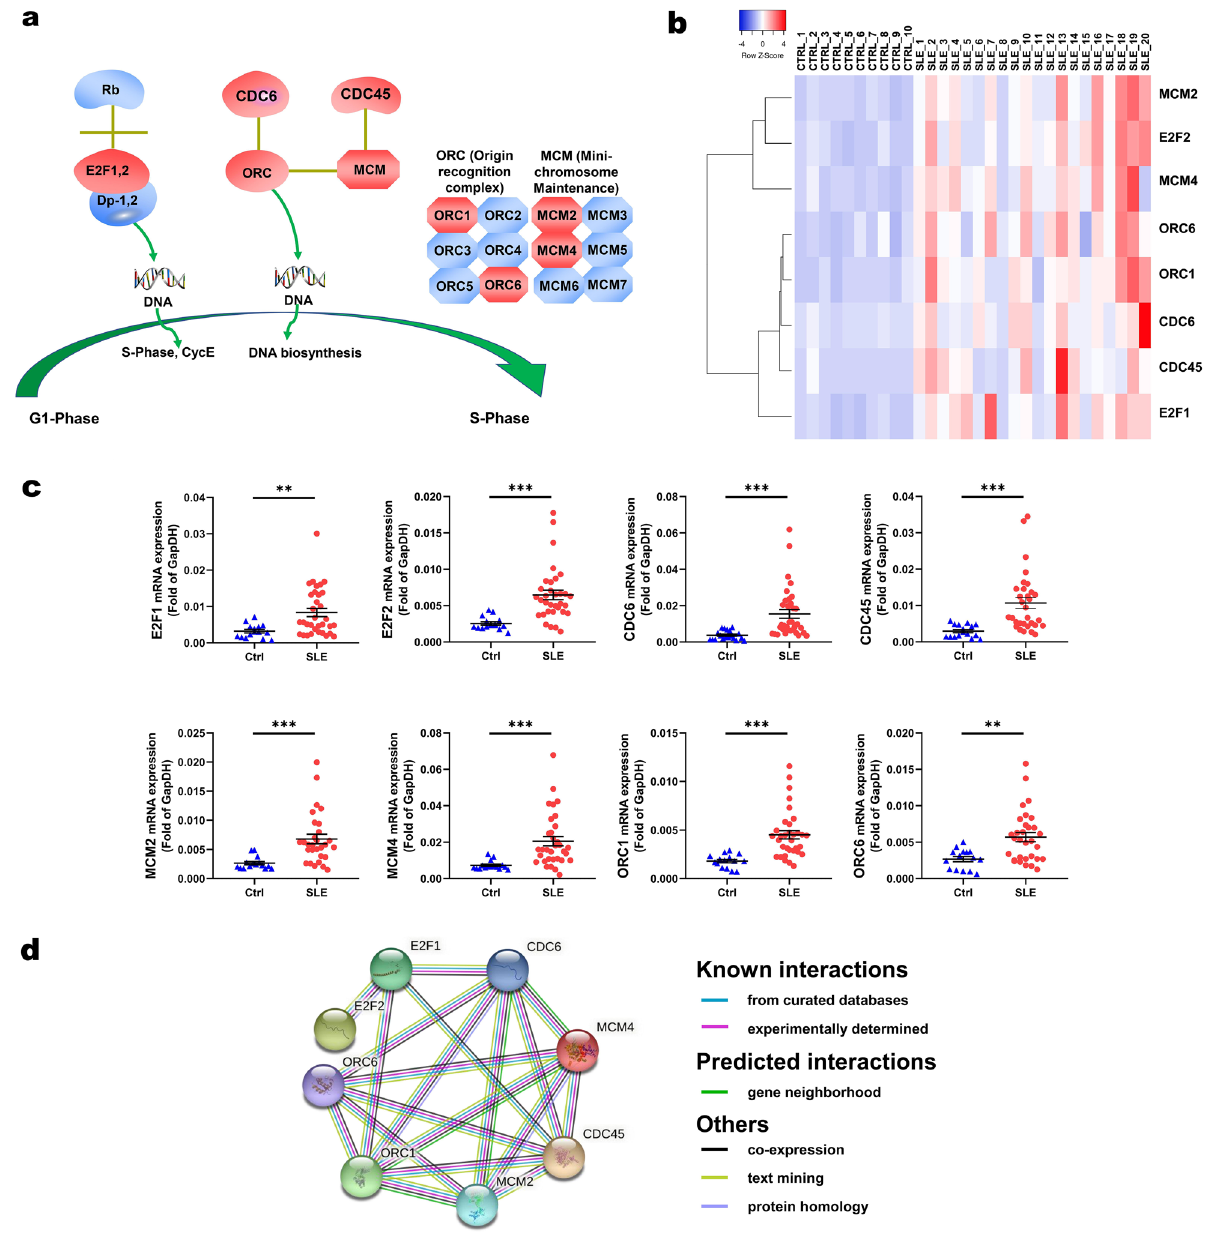
Figure 5. Upregulated genes mapped to cell cycle pathway. (a) Model diagram of a part of the cell cycle pathway, genes marked in red are significantly upregulated genes. (b) Cluster analysis was performed on 8 genes with significant differences between the systemic lupus erythematosus (SLE) group and the control (CTRL) group. (c) Quantitative real-time PCR (qRT-PCR) validation of some differentially expressed genes mapped to cell cycle pathway. *** P < 0.001, ** P < 0.01, * P < 0.05. (d) Diagram of protein–protein interaction (PPI) network showing the evidence of the relationships among the proteins. The known or predicted 3D structure of the protein was shown inside the circles. The types of interaction evidence are